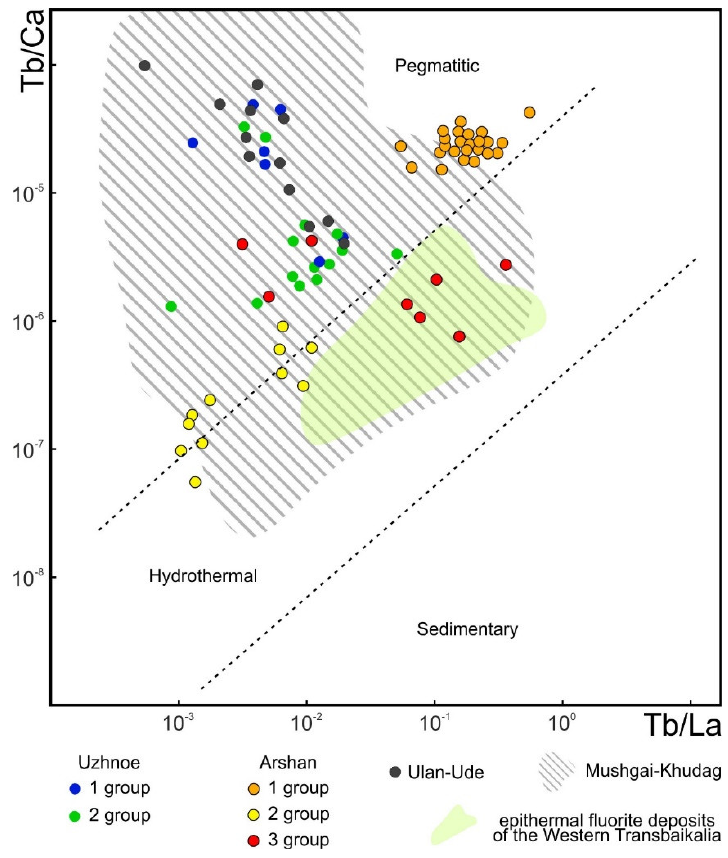
Figure 5. Tb/Ca vs. Tb/La diagram for the Transbaikalia fluorites (epithermal fluorite deposits of the Western Transbaikalia [10]; Mushgai-Khudag [7].